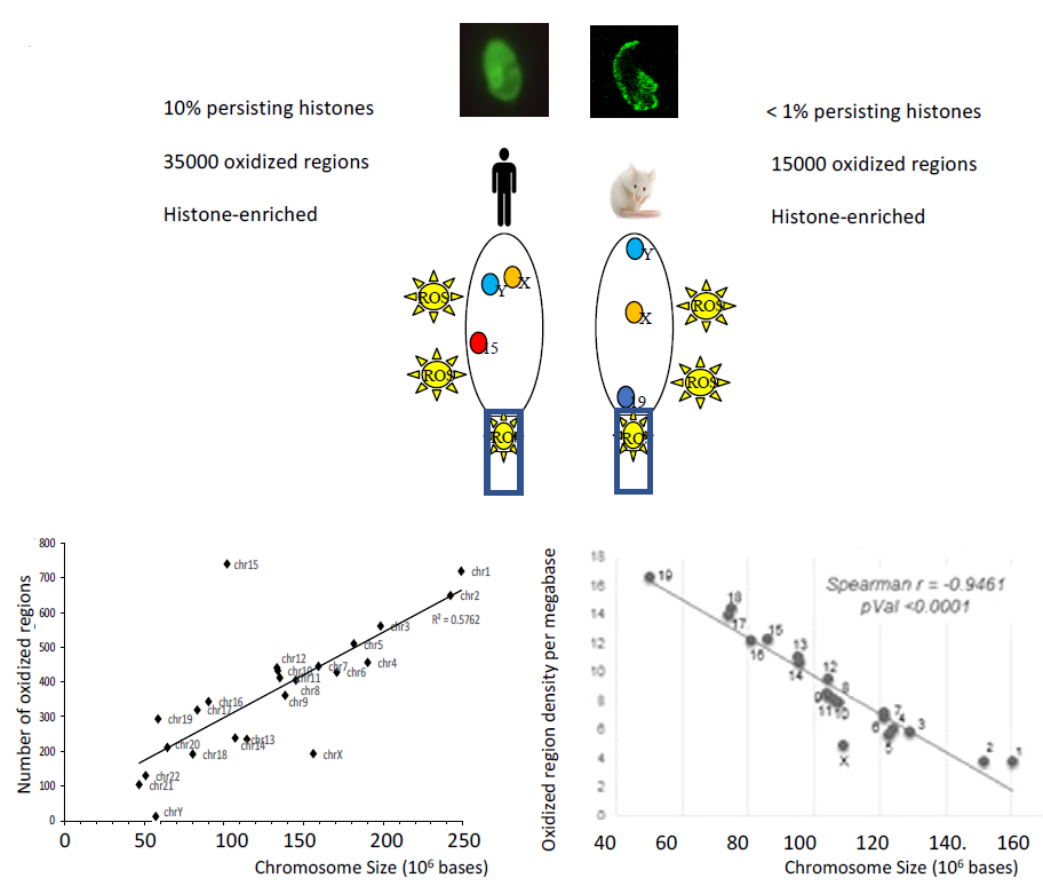
Figure 5. The nuclear regions sensitive to oxidation depend on the chromatin organization of the sperm cells, which is species-specific. In humans and mice, DNA oxidative alterations of spermatozoa revealed by the presence of 8-OHdG residues by fluorescent confocal microscopy show distinct patterns. The low nuclear condensation state of human spermatozoa in which a large part of the chromatin is still in a nucleosomal organization (i.e., associated with persistent histones) explains why 8-OHdG residues are found throughout the sperm nucleus and why there are so many oxidized domains. This low state of nuclear compaction is also illustrated by the observation that the number of oxidized regions follows a linear relationship with the length of the chromosomes. In the more compacted mouse sperm nucleus containing few histone-bound nucleosomes, the regions sensitive to oxidation are more peripheral and less numerous. In this less accessible context, the linear relationship between chromosome length and the number of oxidized regions is no longer valid and only the most exposed (peripheral) chromosomes are a ff ected by oxidative alterations (as illustrated by autosome 19 and chromosome Y [21,25]). In both species, the more chromosomes are located at the periphery of the sperm nucleus the more sensitive they will be to oxidative DNA damage [21,25,26]. In both species, oxidized nuclear regions are regions enriched with persistent histones